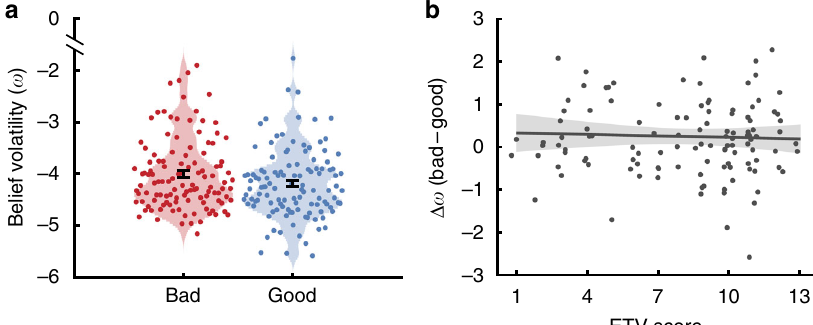
Fig. 2 Objective harm learning does not covary with exposure to violence. a Beliefs about the bad agent ’ s harm preferences were more volatile than beliefs about the good agent ’ s harm preferences. b Between-agent asymmetries in belief updating ( Δ ω = bad agent belief volatility − good agent belief volatility) were not related to participant ’ s ETV score, suggesting that exposure to violence does not signi fi cantly impact the underlying processes of objective harm learning. Error bars represent standard error of the mean. Error bands represent 95% con fi dence intervals. Source data are provided as a Source Data fi (Spearman ’ s ρ , good: ρ = 0.025, p = 0.785; bad: ρ = − 0.014, p = 0.879), nor was it related to the difference in ω between good and bad agents ( Δω : ρ = 0.008, p = 0.929; Fig. 2b). Together, these results suggest that objective harm learning was largely intact in this sample and did not covary with exposure to violence.